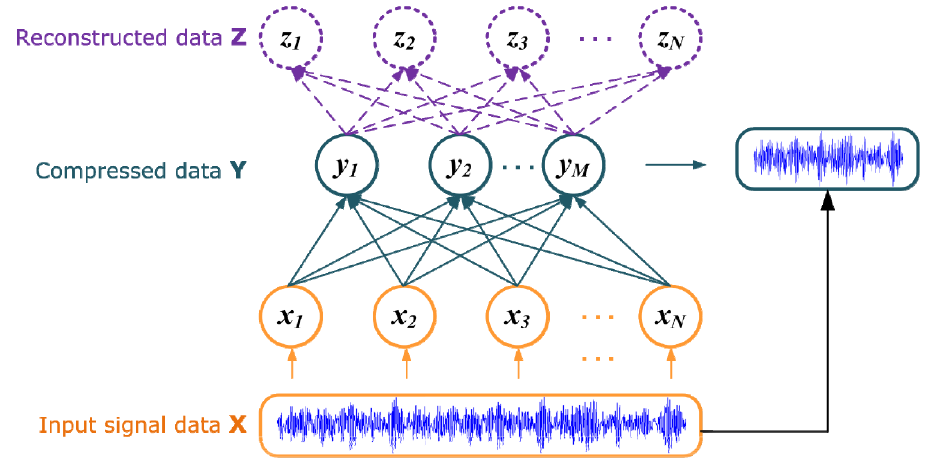
Figure 6. An Auto